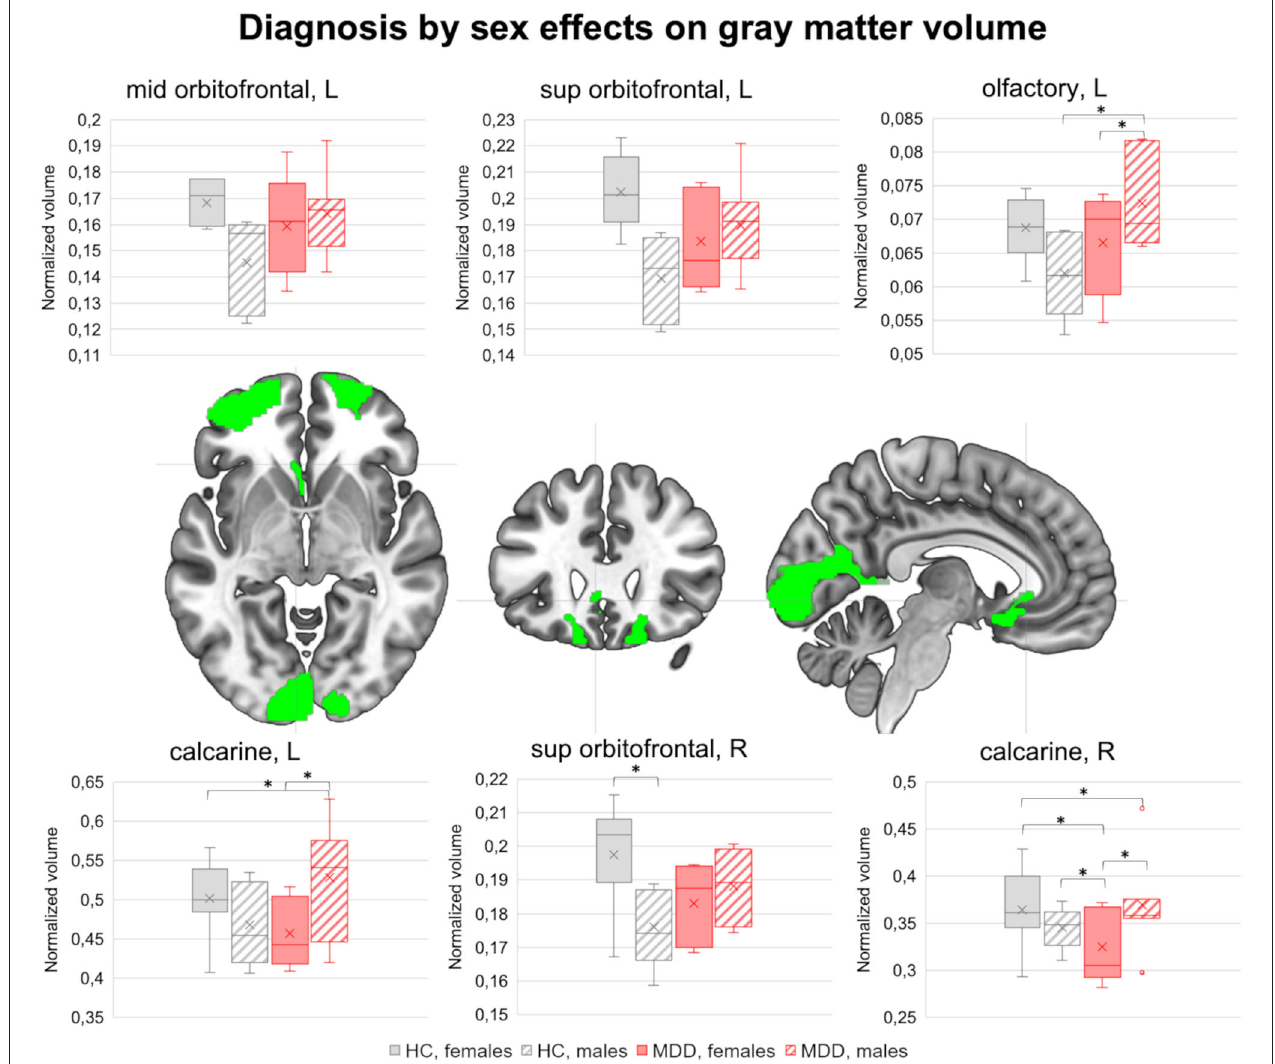
FIGURE 1 | Diagnosis by sex effects on brain morphology. The brain clusters showing sexually dimorphic GM volume differences between MDD and HC groups are highlighted in green ( p < 0.05). In the top and bottom rows, the boxplots represent the normalized GM volume distribution in HC females, HC males, MDD females, and MDD males. Pairwise differences between diagnosis by sex subsets (net of age and ITV) are highlighted ( p < 0.05). GM, gray matter; MDD, major depressive disorder; HC, healthy controls; L, left; R, right. *significant pairwise differences ( p <